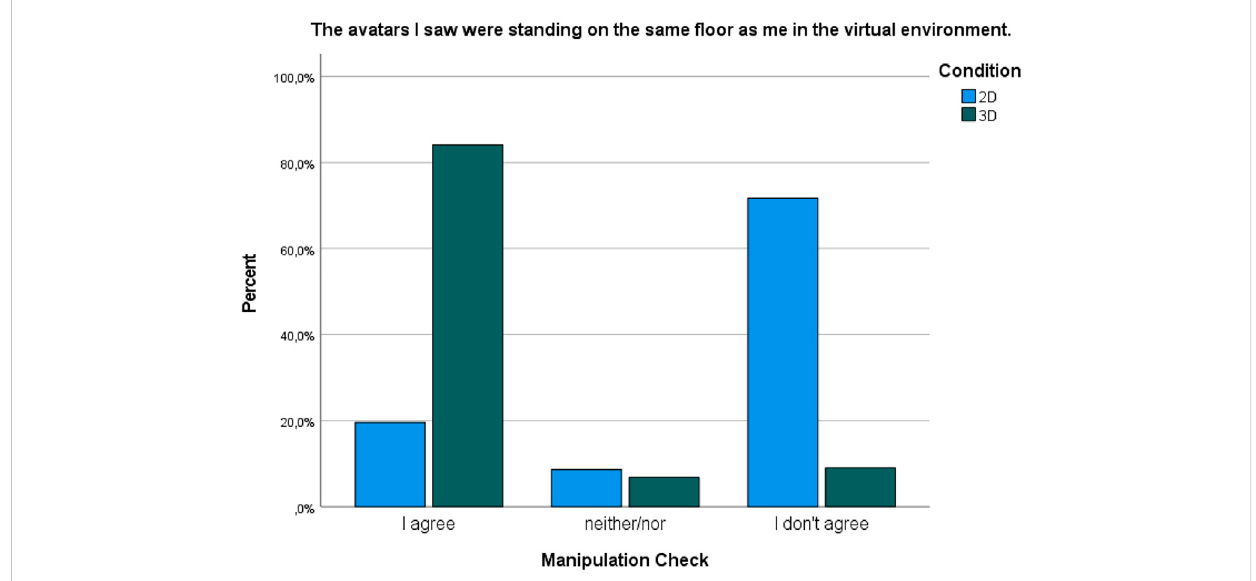
Distributionofanswerfrequenciesforthetreatmentcheckitem “ TheavatarsIsawwerestandingonthesame fl